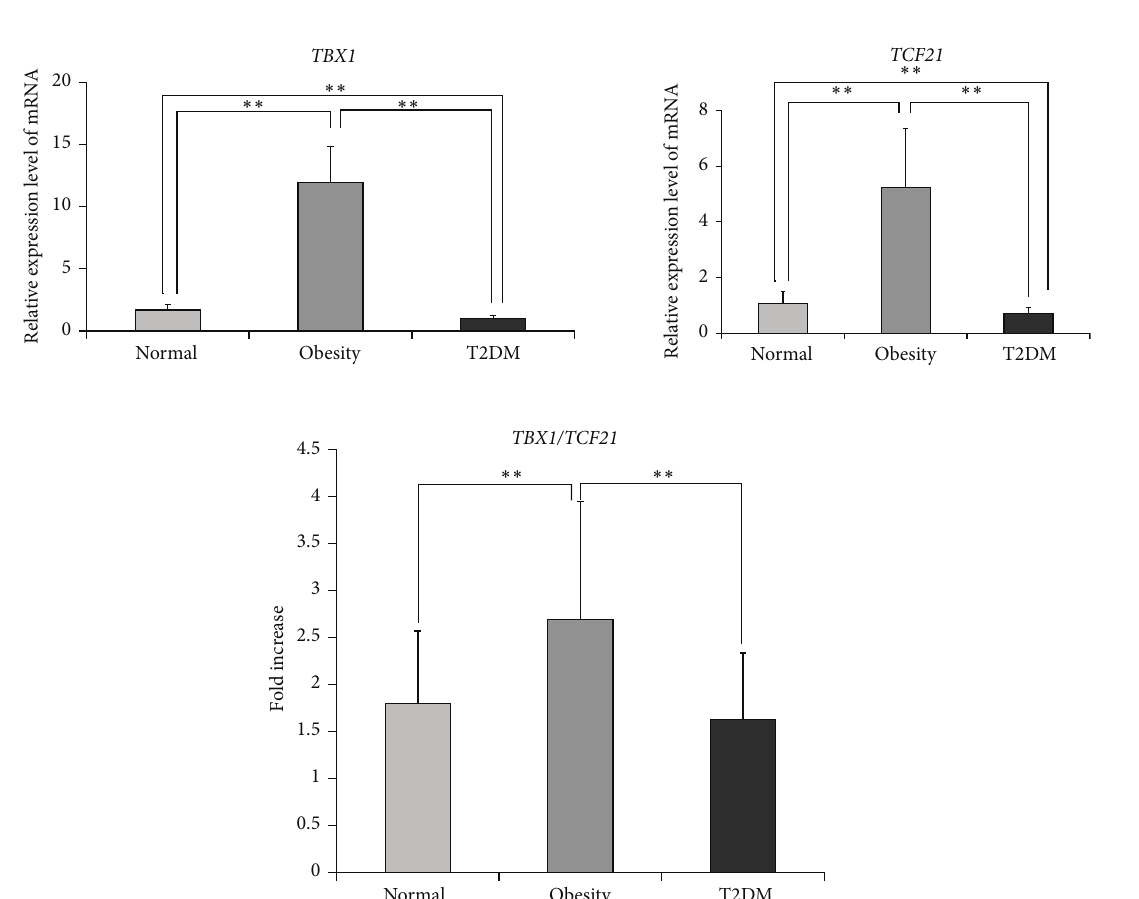
Figure 1: The mRNA expression levels of T-box protein 1 ( TBX1 ) and transcription factor 21 ( TCF21 ) in the visceral adipose tissue of Uygur population. Comparison between groups by 𝑡 -test, ∗∗ 𝑃 < 0.01 ; 𝑛 = all subjects in each group (50, 48, and 26 for the normal, obesity, and T2DM groups, resp.); T2DM, type 2 diabetes